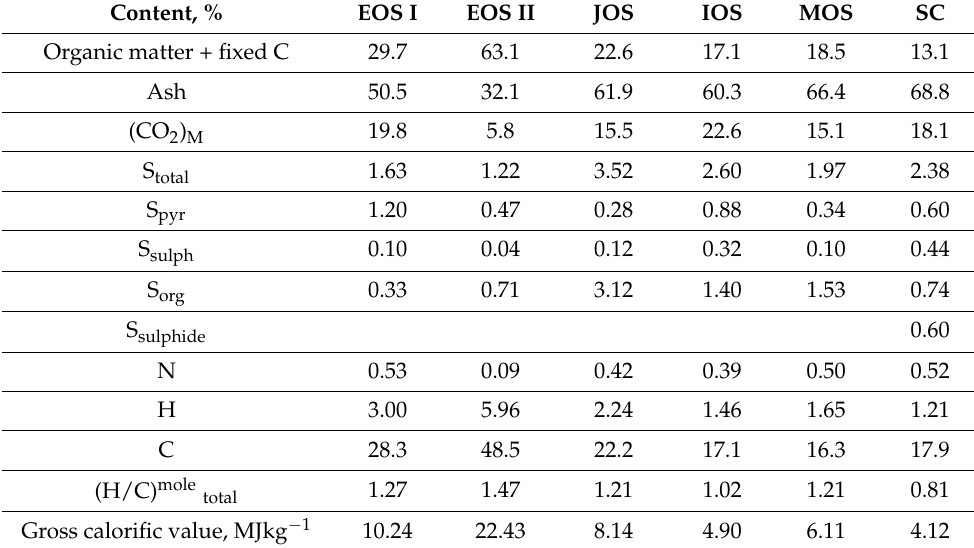
Table 1. Main characteristics of sample (on dry